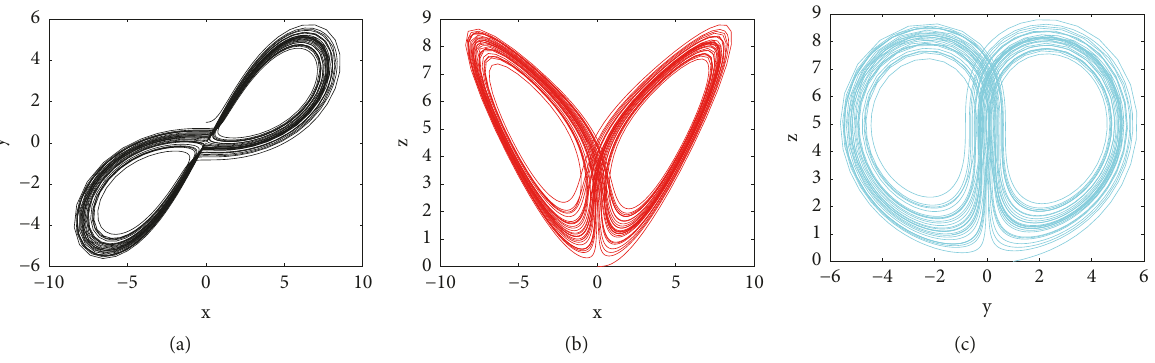
Figure 5: Strange attractors of chaotic system for Experiment 2 at 𝑏 = 2 : (a) (𝑥,𝑦) -plane; (b) (𝑥,𝑧) -plane; (c) (𝑦, 𝑧) -plane.